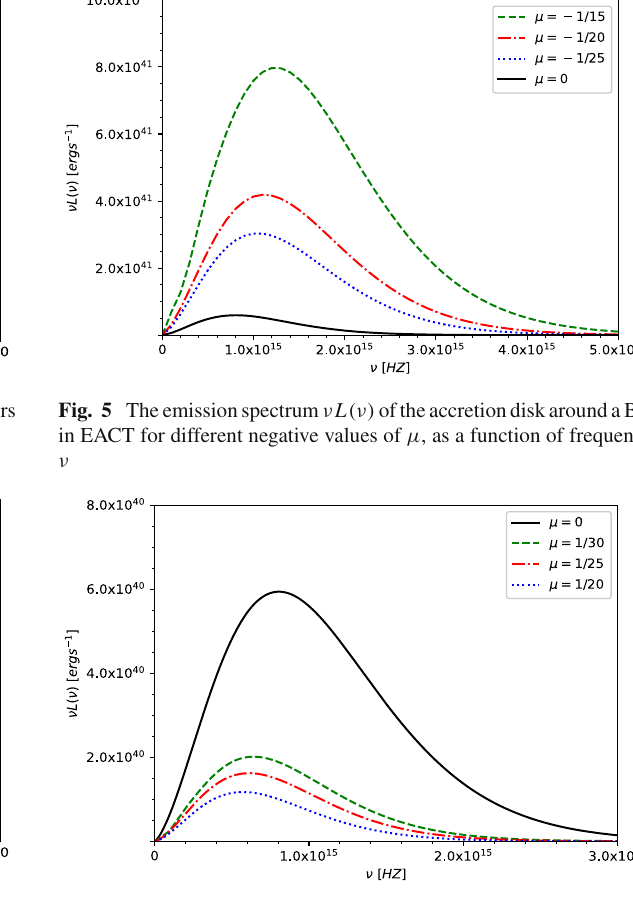
Fig. 6 Theemissionspectrum ν L (ν)